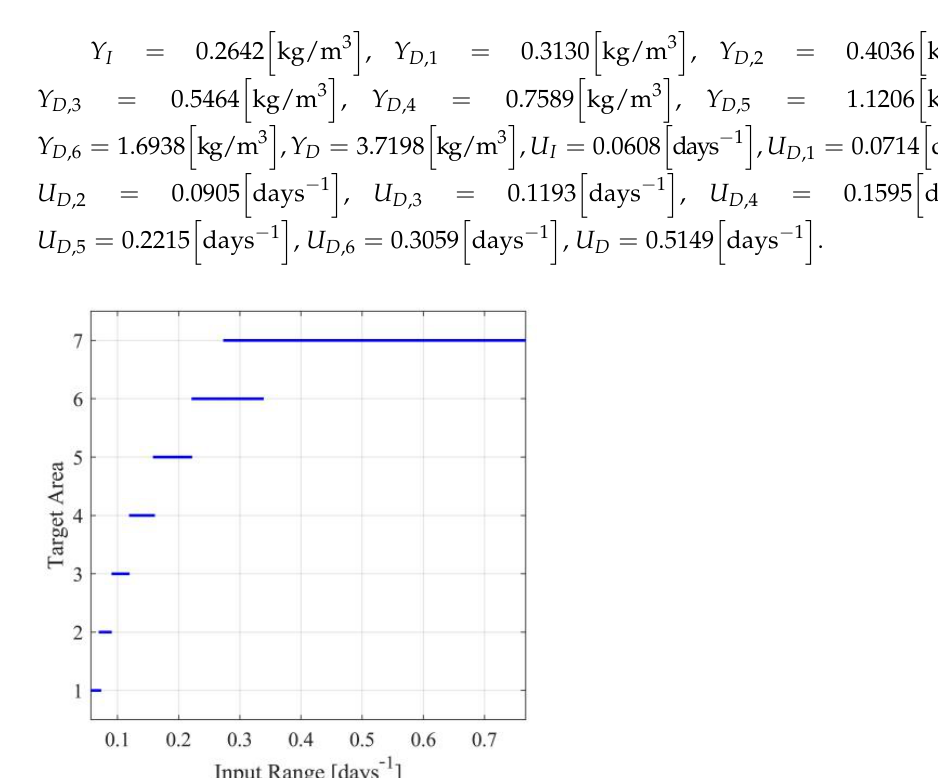
( b ) Figure 4. ( a ) Substrate concentration response/estimation; ( b ) Microorganism concentration re- sponse/estimation.